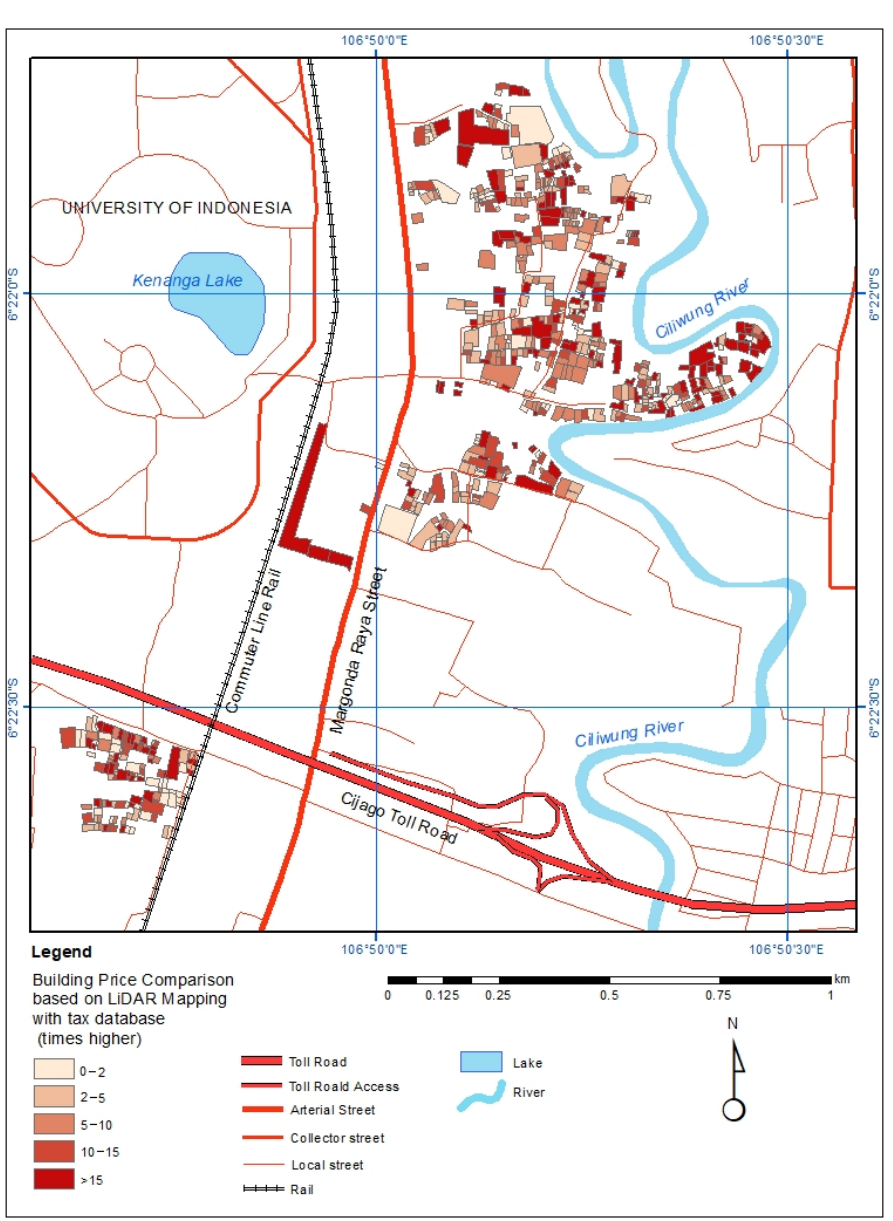
Figure 10. Comparison map of building prices based on LiDAR mapping with tax databases (source: data processing documentation) .